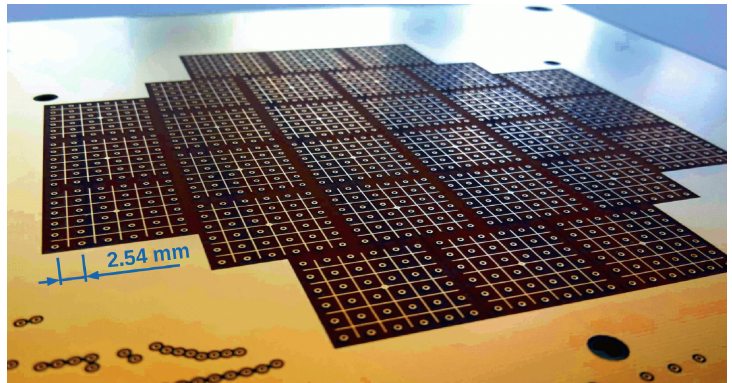
Figure 1. Initial (July 2016) prototype pixelated anode PCB. The pixelated readout area is 100mm in diameter. Each charge collection pixel is a 900µm via, at a pitch of 2.54mm, inductive focusing grids formed of 152.4µm copper traces surround the pixels. The inductive focusing grid is split into 28 Regions of Interest (ROIs). There are 36 pixels per ROI, a total of 1008 pixels.